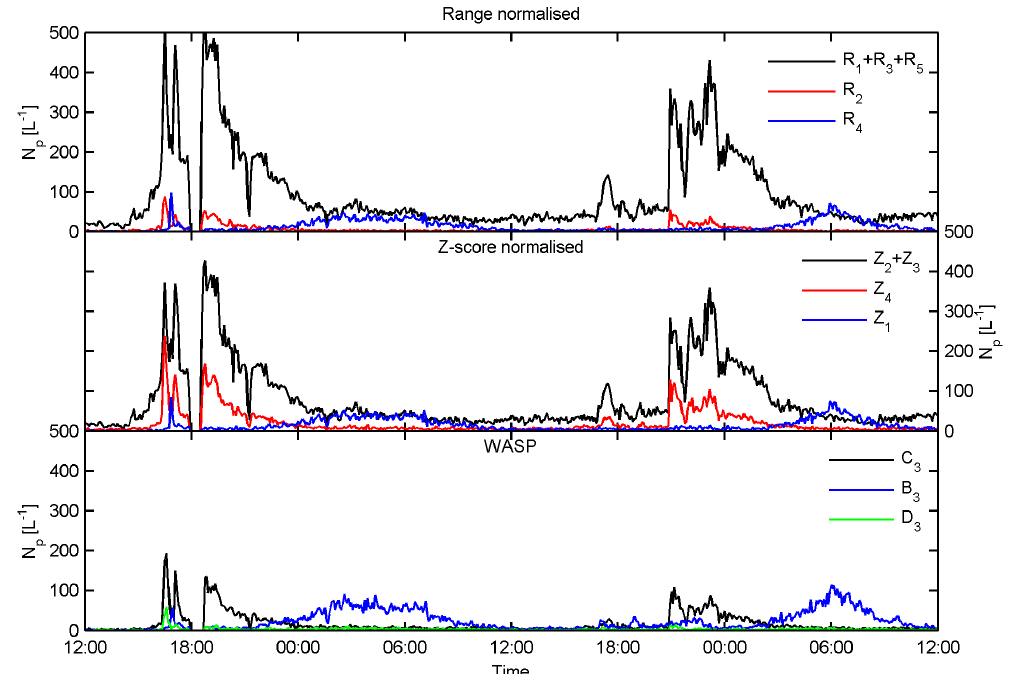
Figure 6. Time series of BEACHON-RoMBAS cluster concentrations using Ward linkage with range (top panel) and z -score (middle panel) normalisation as compared to the solutions obtained using WASP (bottom panel) for the period 00:00MST (Mountain Standard Time) on 26 July 2011 to 12:00MST on 28 July 2011. Clusters with similar centroids have been combined. See text for details.